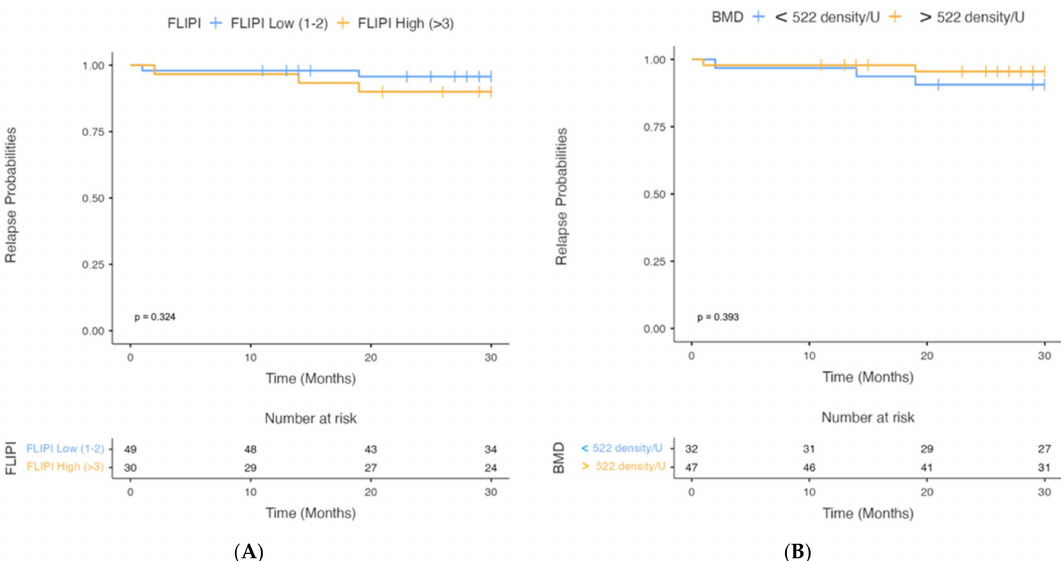
Figure 4. Prediction analysis of radiomic parameters and the outcomes of patients with low or high FLIPI Scores.